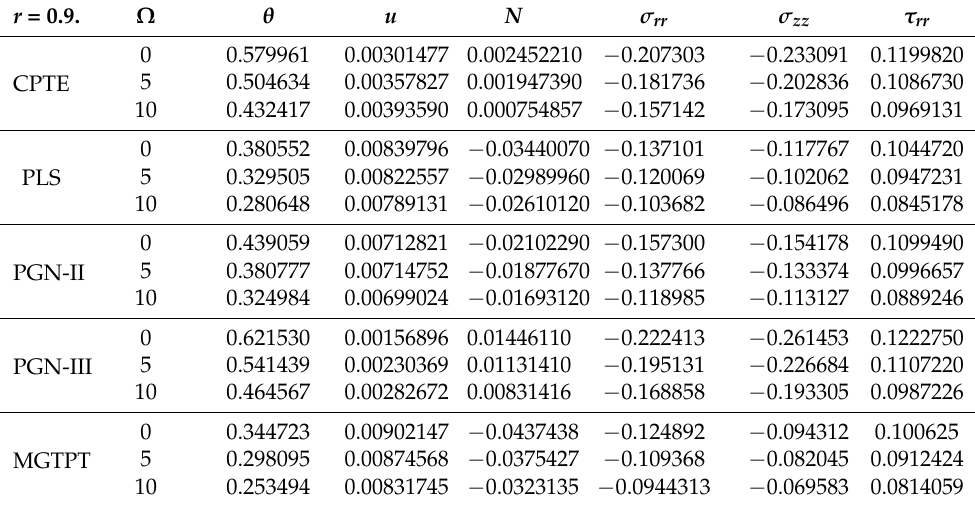
Table 7. The variation of different photothermal fields with different rotation parameter Ω . r = 0.9.